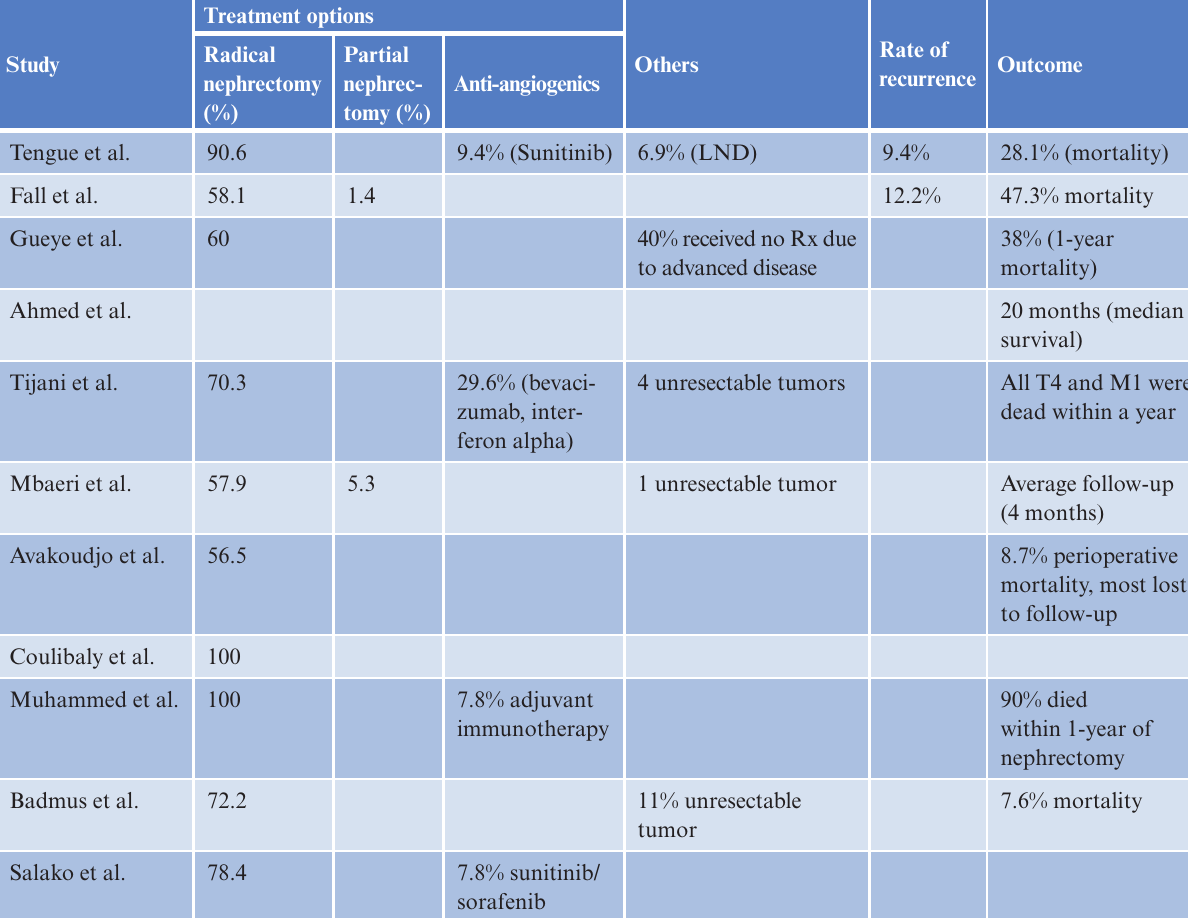
Table 4: Treatment modalities for renal tumors and outcome of the disease and treatment in sub-Saharan Africa